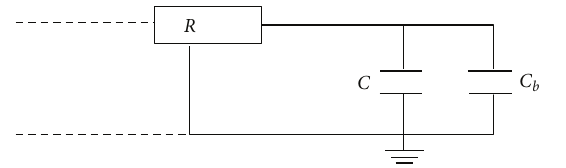
Figure 11: RC model for sensor with C b (bu ff er capacitance) in